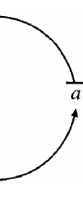
Figure 1. Hoop net ([3], p. 48).